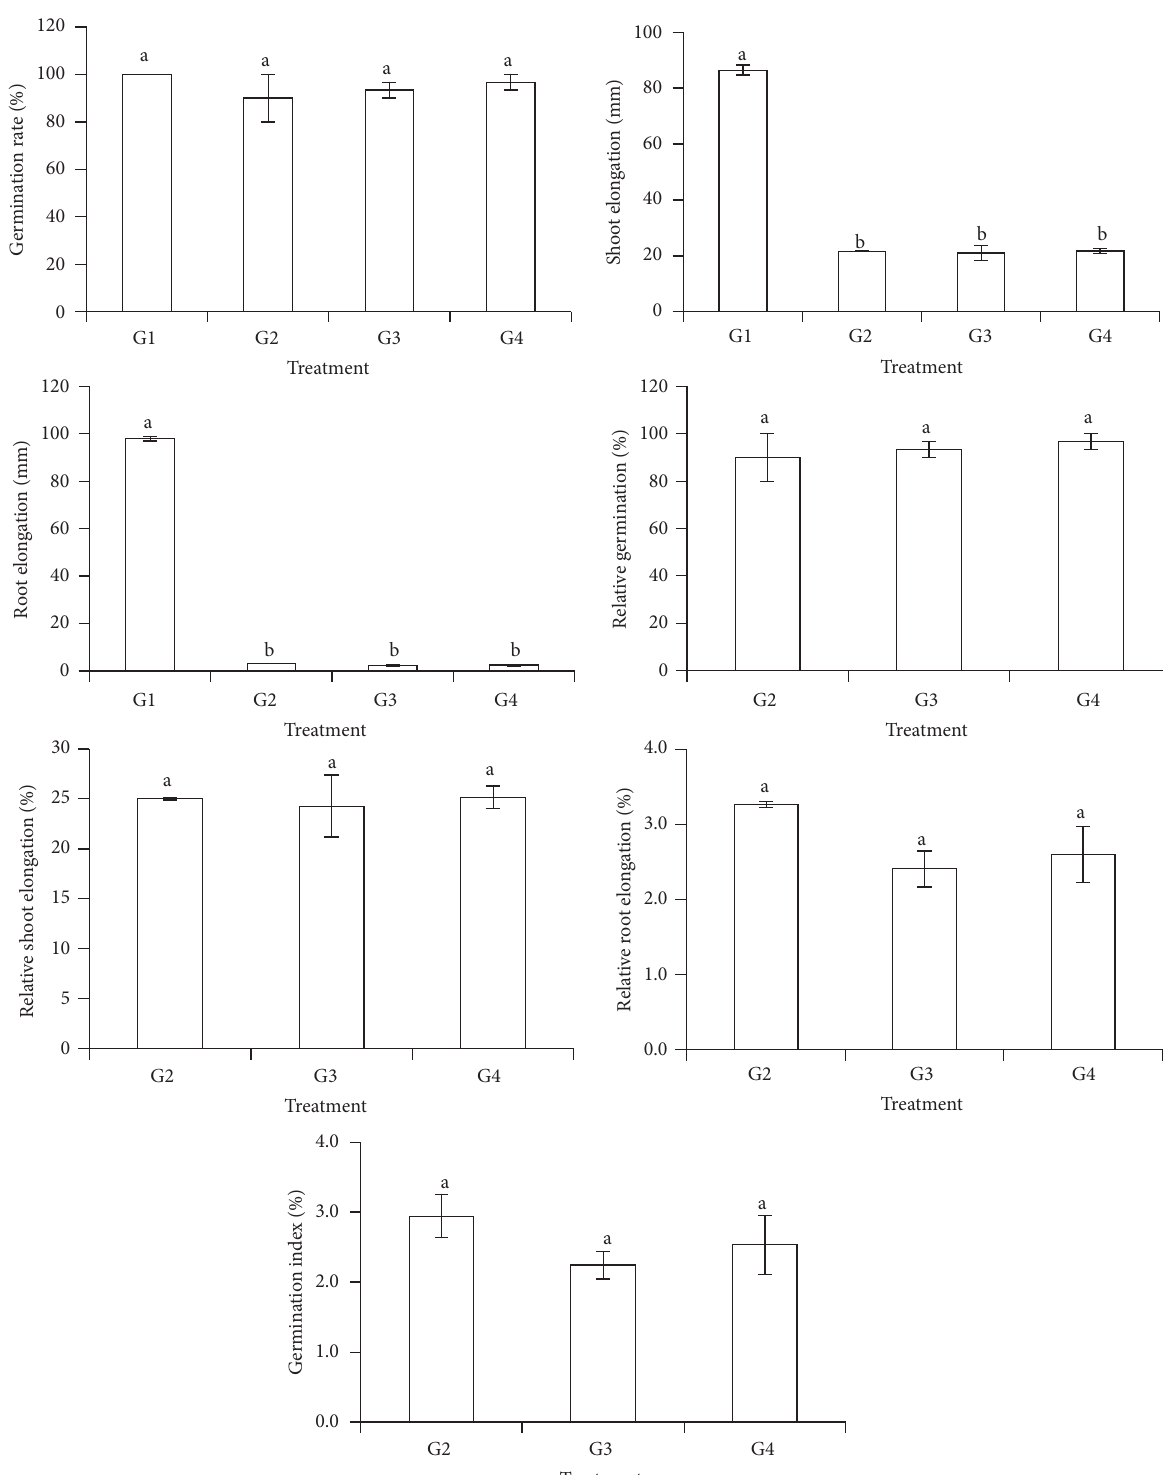
Figure 3: Treatments (G1: 100% sand, G2: 5% rice straw compost + 95% sand, G3: 10% rice straw compost + 80% sand, and G4: 15% rice straw compost + 85% sand) effect on rice seeds germination rate, shoot elongation, root elongation, relative germination, relative shoot elongation, relative root elongation, and germination index of rice seedlings at 7 days after seeding. Different alphabets indicate significant difference between means using Tukey’s test at 𝑃 ≤ 0.05 . The error bars are the ± standard error of